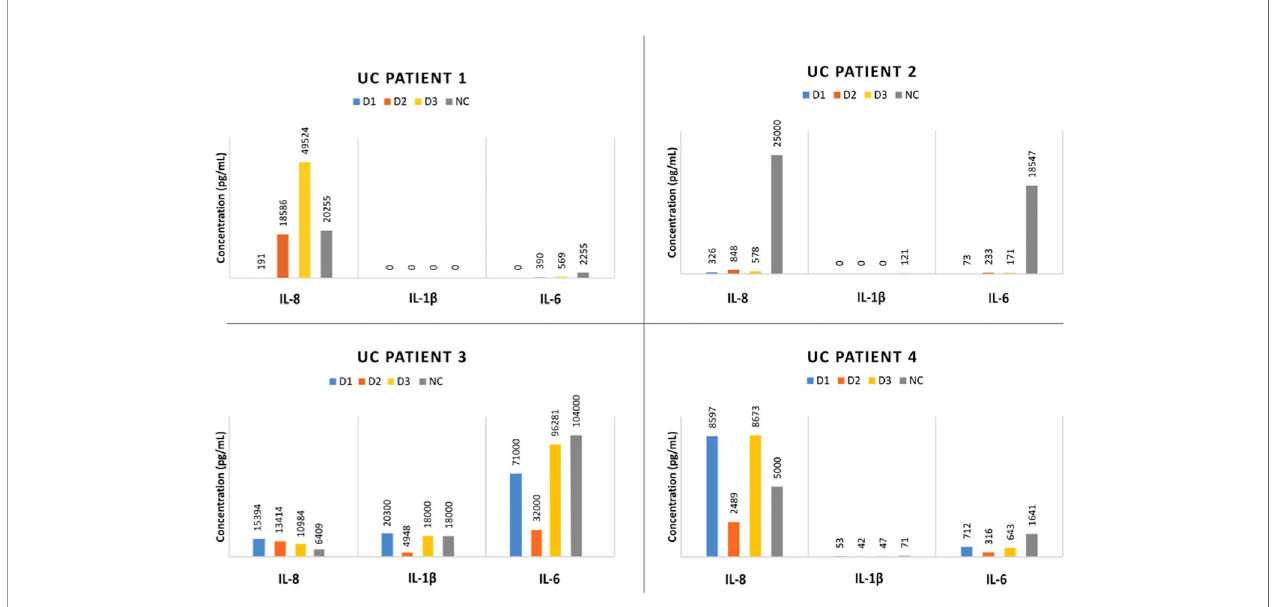
FIGURE 4 | Results from in vivo evaluation of the test using 4 patients with ulcerative colitis (UC). Each quadrant showed the cytokine production of each patient against the 3 donor candidates ’ microbiota. The basal cytokine production (without any antigenic stimulus) of the immunocompetent cells is also depicted (named as NC, negative